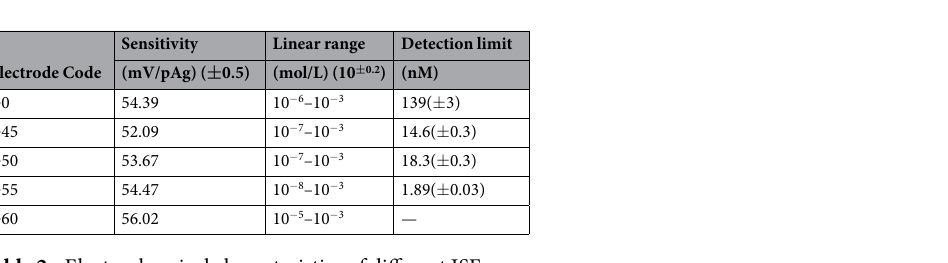
Table 2. Electrochemical characteristics of different